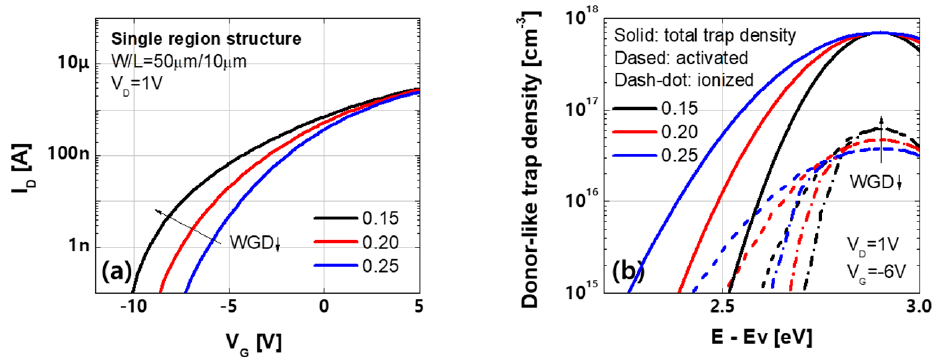
Figure 11. ( a ) Transfer characteristic with various widths of donor–like Gaussian states (WGD)